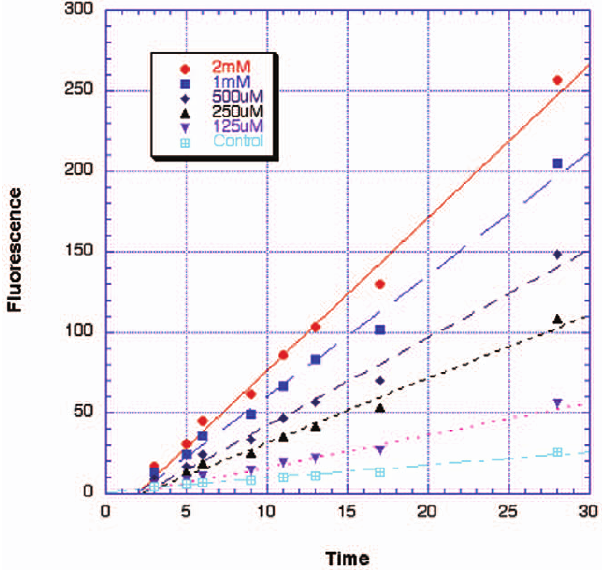
Figure 3. Adipocyte cell culture-based determination of AOC3 turnover in the presence of varying concentrations of methyl- amine substrate using the Amplex Red peroxide detection